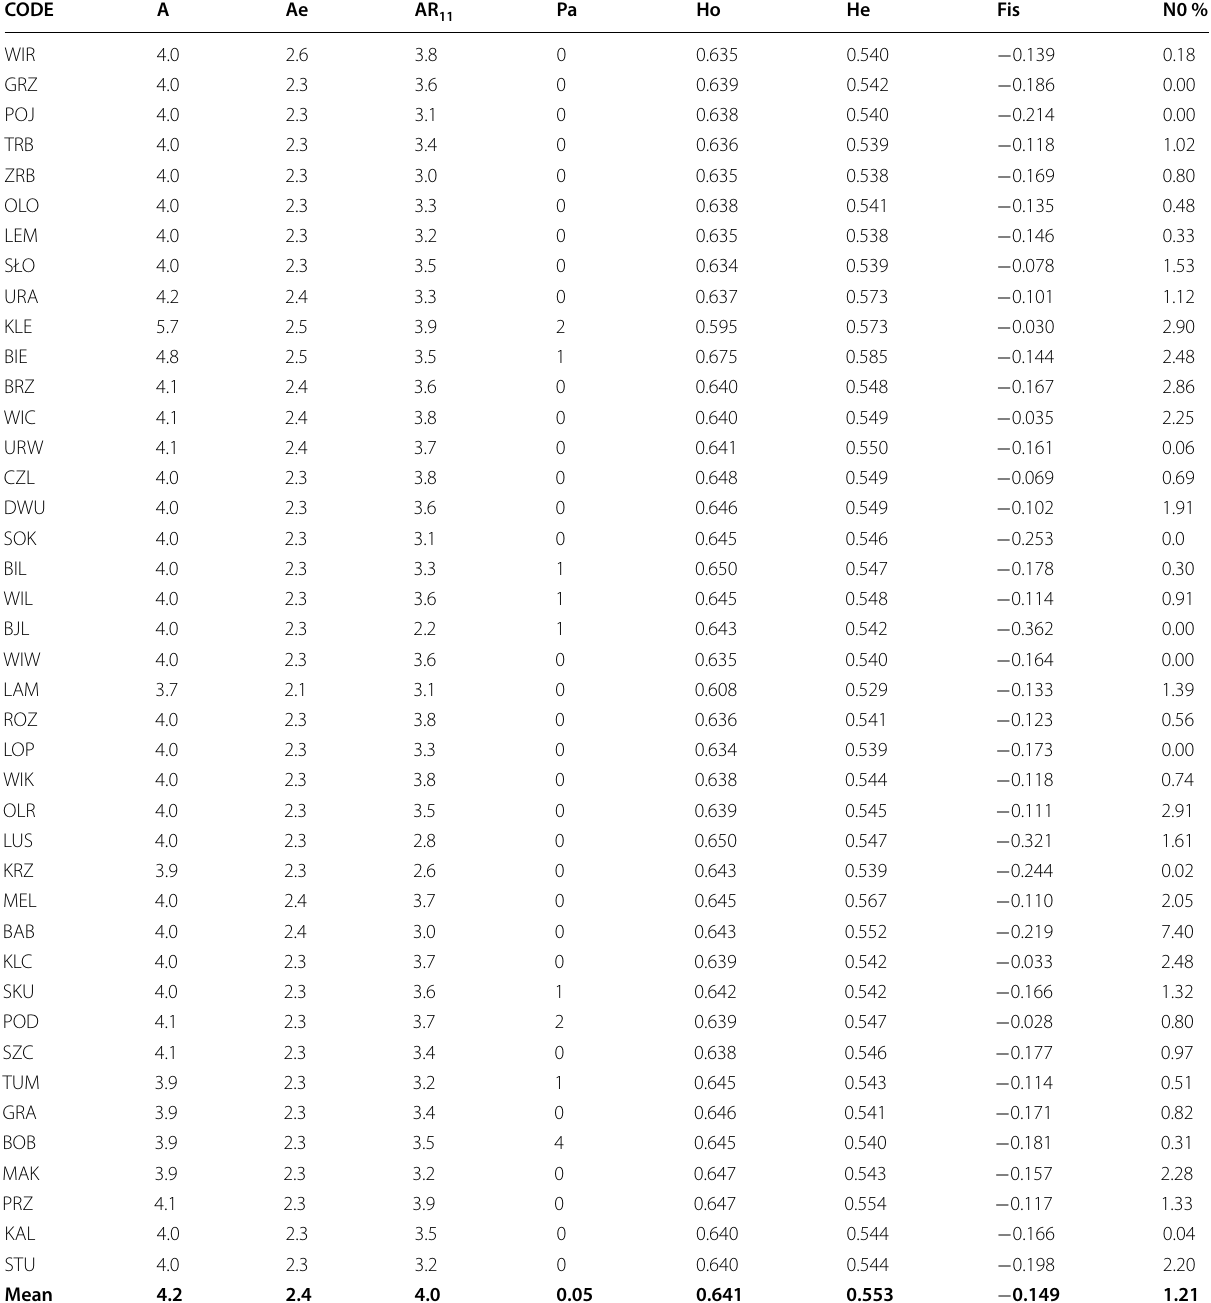
Table 2 Parameters used to estimate the genetic structure of the Ulmus laevis populations studied, averaged across six nuclear microsatellite